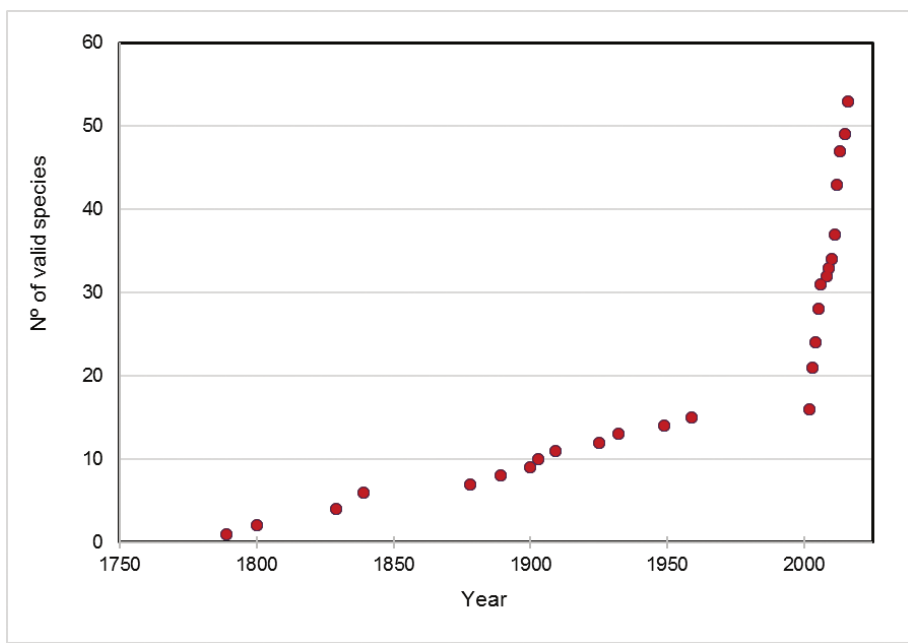
Figure 5. Cumulative number of valid named Buthus species. Only current valid species' names were plotted; in the year they were first